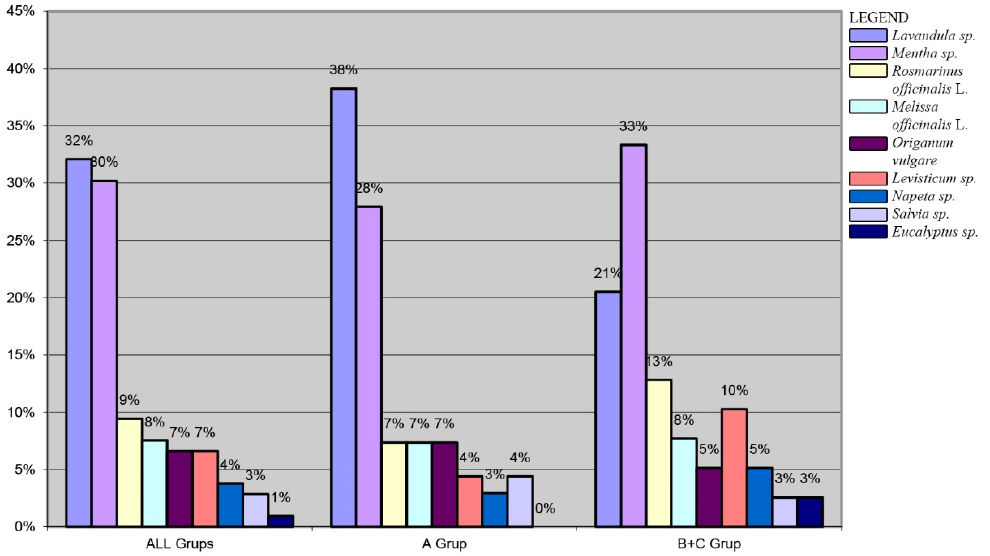
Figure 3. Results presenting associations with a smell that held particular significance to respondents divided into two age groups—young people up to 29 years of age (group A) and aged 30 and above (groups B and C).